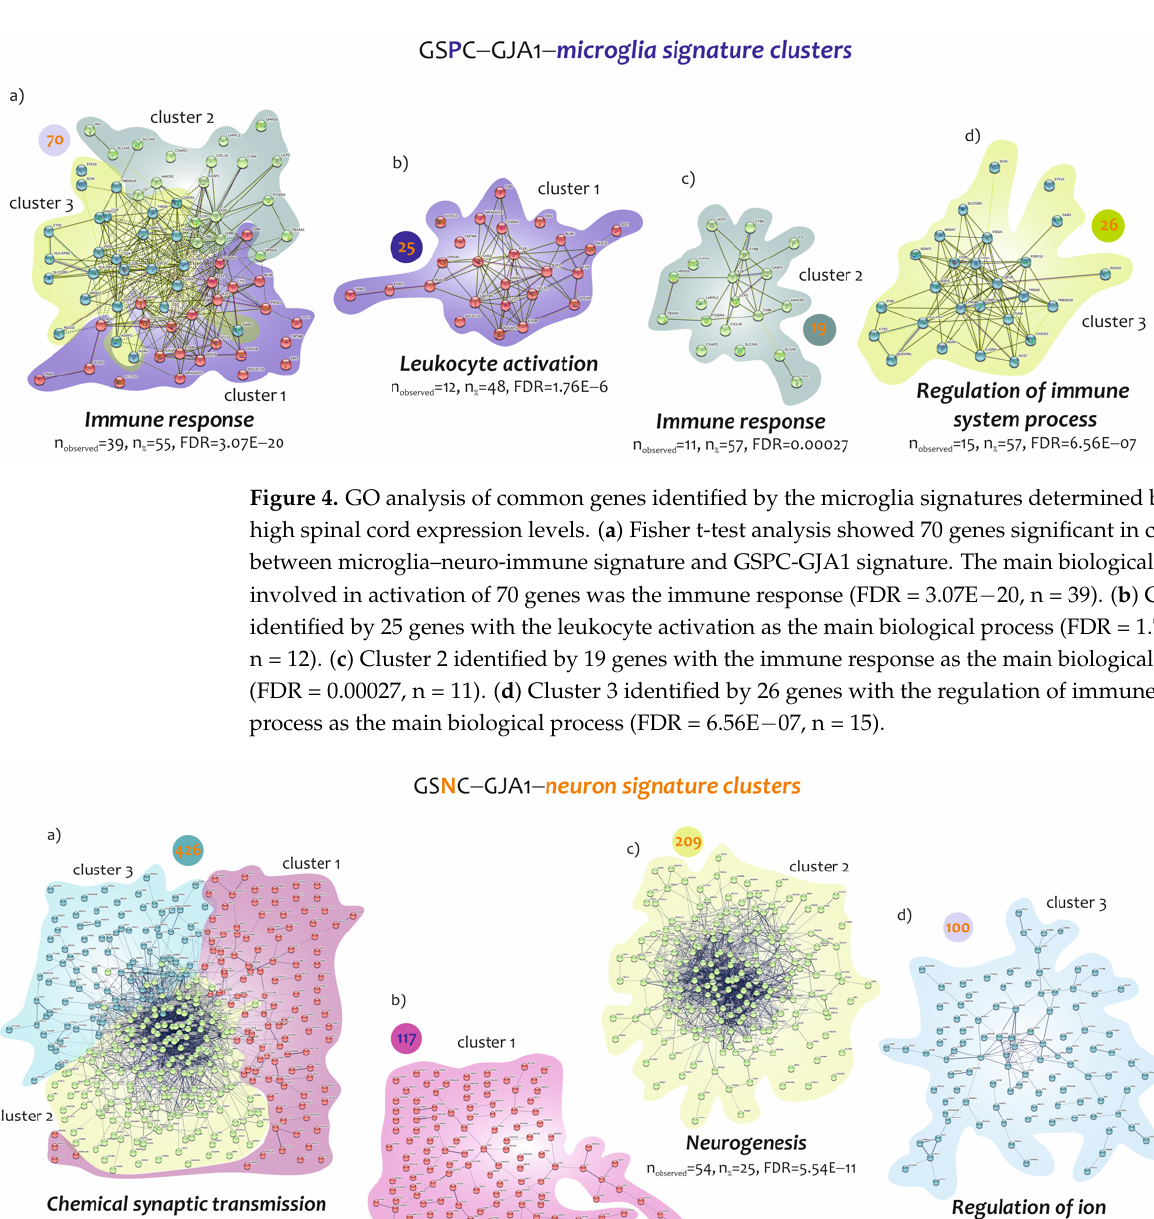
Figure 4. GO analysis of common genes identified by the microglia signatures determined by GJA1 high spinal cord expression levels. ( a ) Fisher t ‐ test analysis showed 70 genes significant in common between microglia–neuro ‐ immune signature and GSPC ‐ GJA1 signature. The main biological pro ‐ cess involved in activation of 70 genes was the immune response (FDR = 3.07E − 20, n = 39). ( b ) Cluster 1 identified by 25 genes with the leukocyte activation as the main biological process (FDR = 1.76E − 06, n = 12). ( c ) Cluster 2 identified by 19 genes with the immune response as the main biological process (FDR = 0.00027, n = 11). ( d ) Cluster 3 identified by 26 genes with the regulation of immune system process as the main biological process (FDR = 6.56E − 07, n = 15).